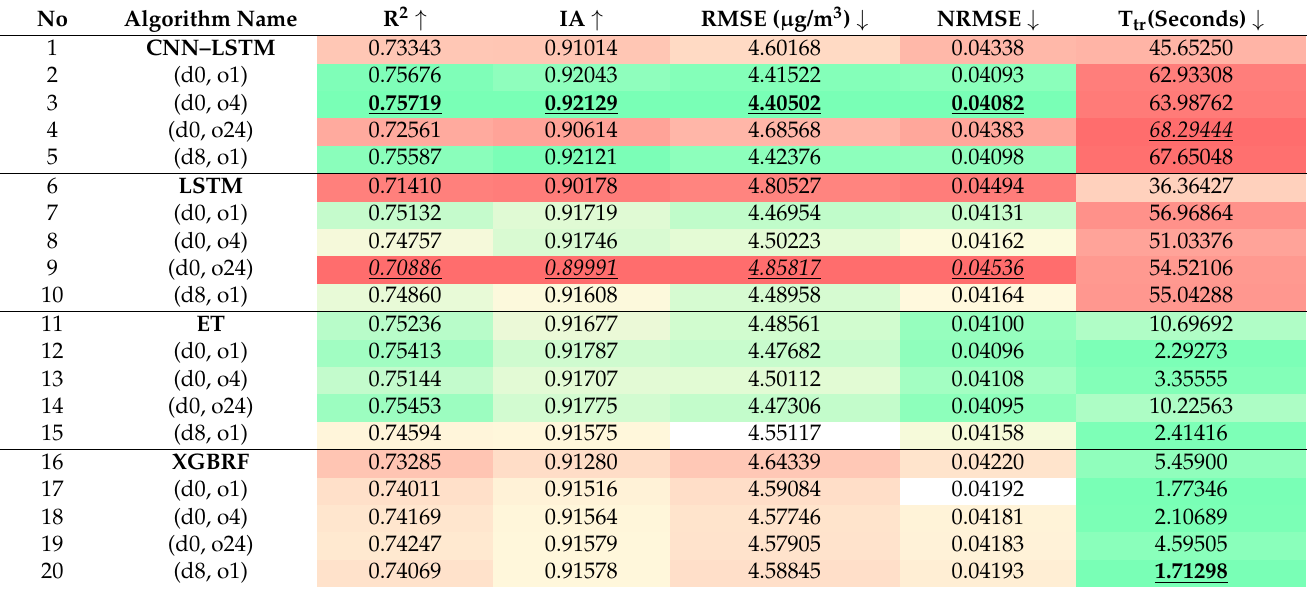
Table 6. Prediction evaluation metrics averaged for Timeseries K-Fold = 10 for Manchester, UK dataset.